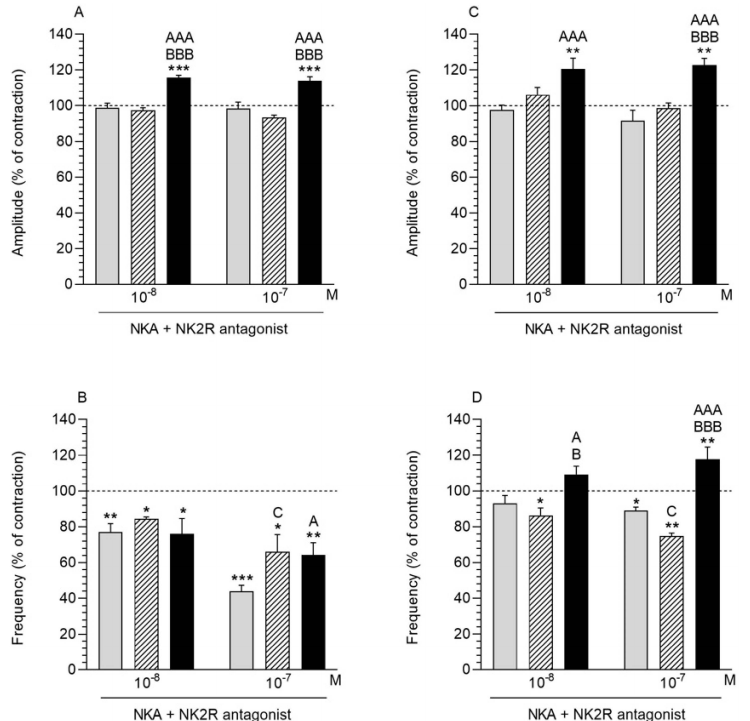
Figure 6. The influence of neurokinin A (NKA) on the contractile amplitude ( A , C ) and frequency ( B , D ) in the myometrium ( A , B ) and endometrium/myometrium ( C , D ) strips of gilts from the CON (grey bars), SAL (hatched bars), and E. coli (black bars) groups after using NK2R antagonist. Results were calculated for five gilts in each group. The effects of antagonist and individual NKA doses